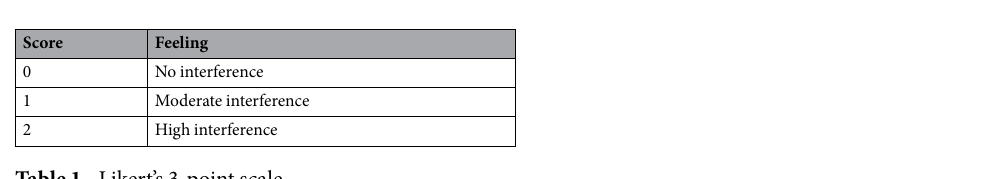
Table 1. Likert’s 3-point